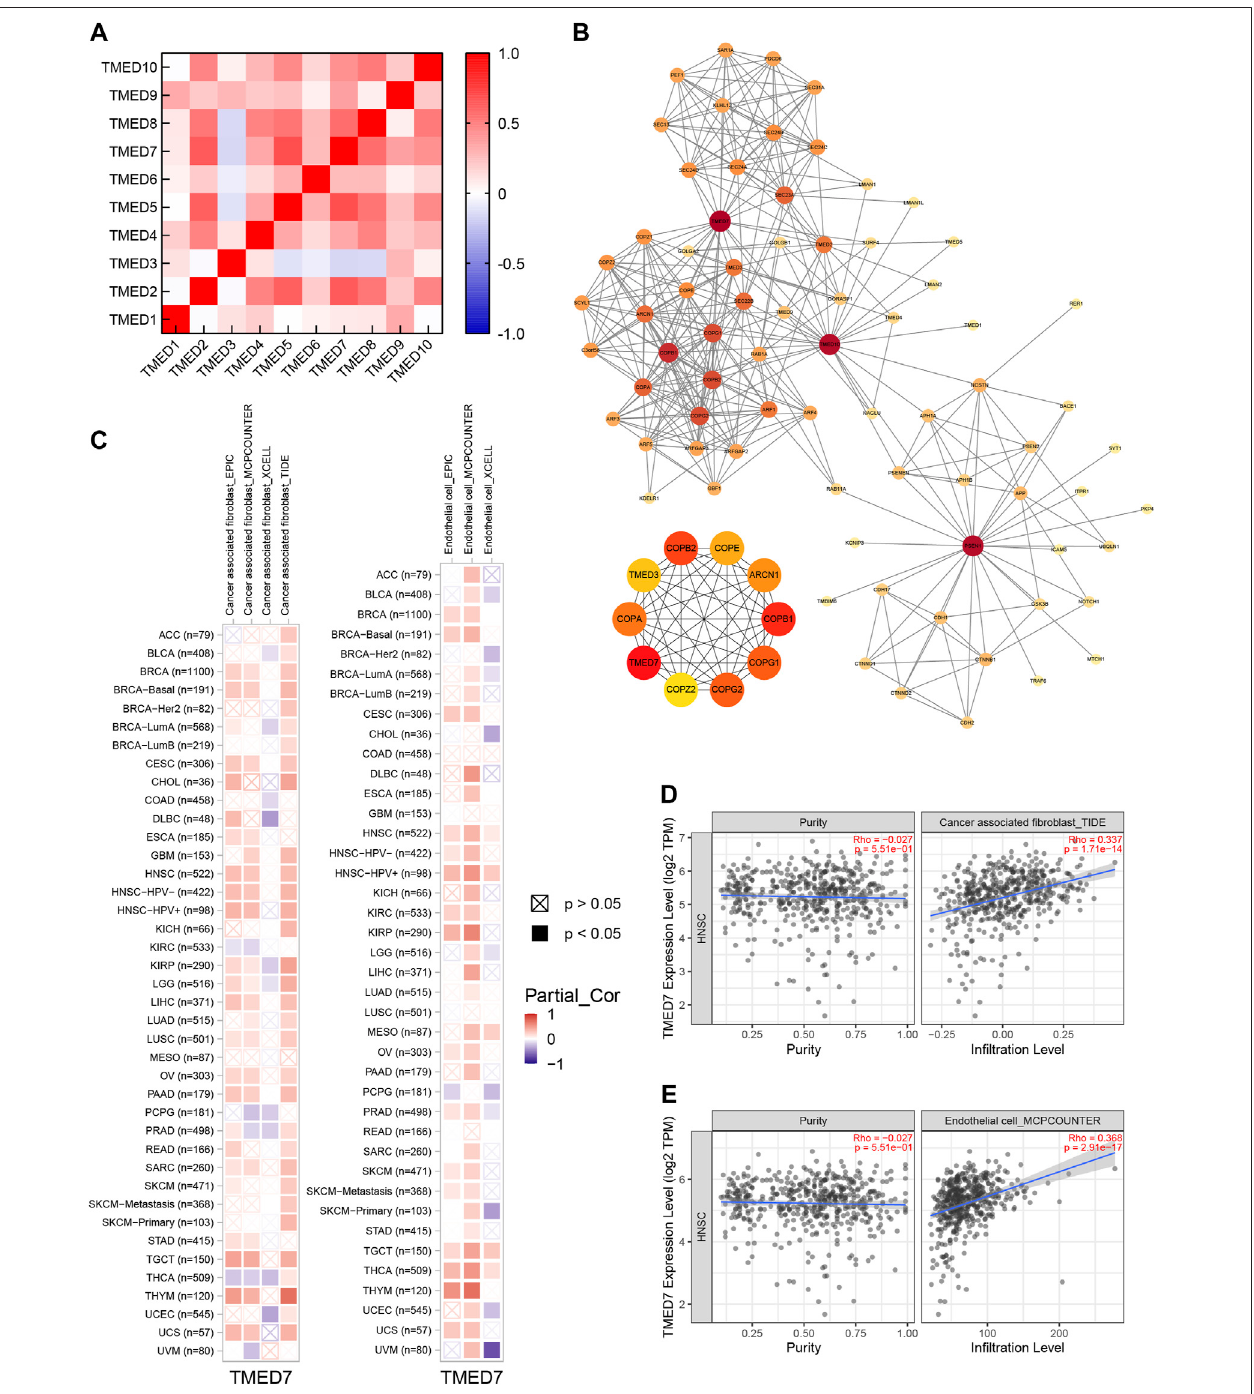
FIGURE 10 | Co-expression and PPI of TMED genes in HNSC. (A) Heatmap of the TMED family proteins correlations in HNSC. (B) Protein-protein interaction network of TMED2/9/10, and the top 10 genes among them. (C – E) TMED7 expression had signi fi cant positive correlations with in fi ltrating levels of fi broblast and endothelial